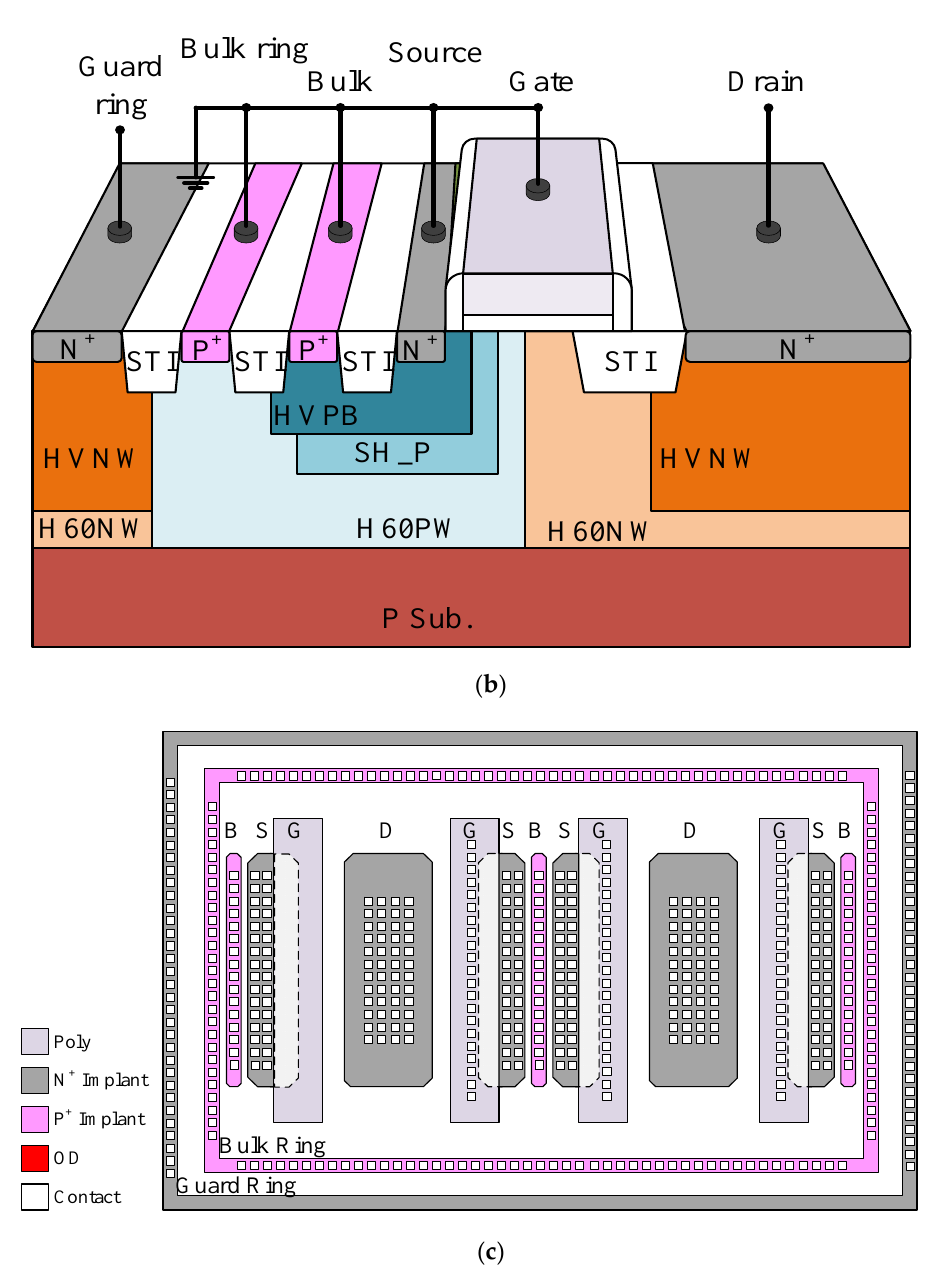
Figure 1. ( a ) Parasitic equivalent circuit & cross-sectional view, ( b ) 3-D structure view, and ( c ) layout diagram of the high-voltage n-channel laterally diffused metal-oxide–semiconductor transistor (HV nLDMOS) reference device.